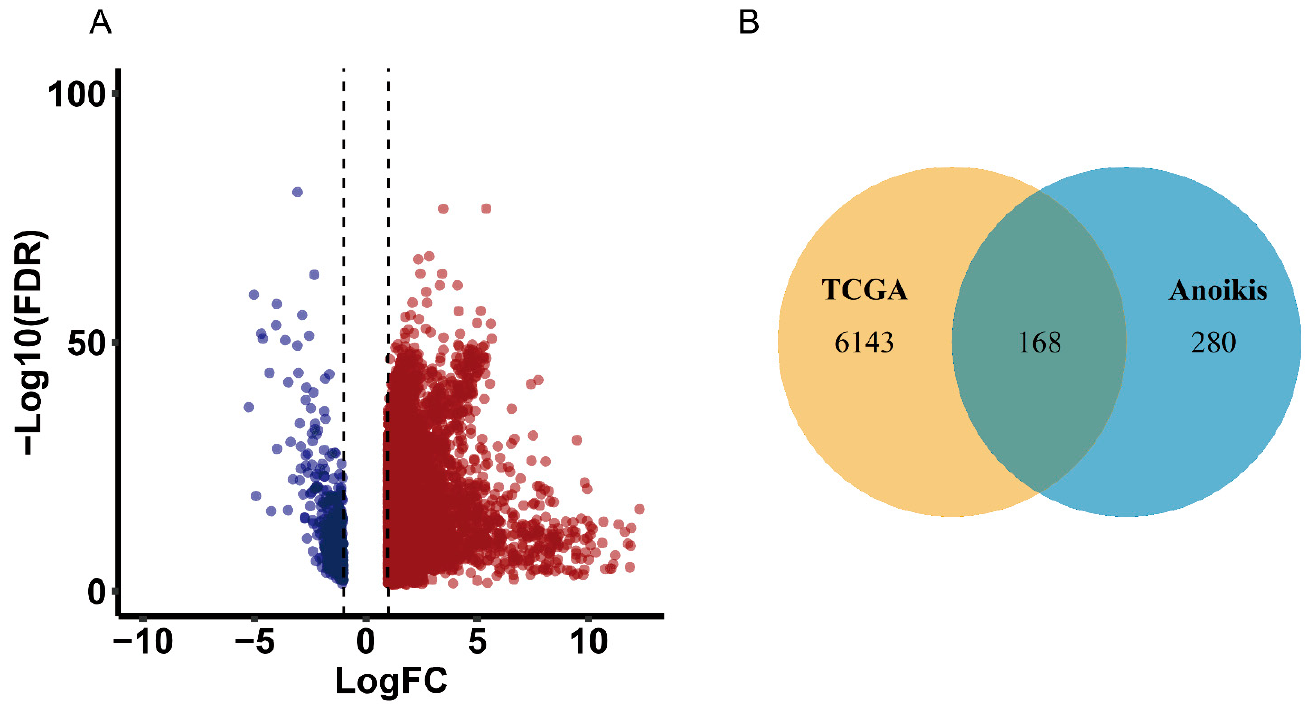
Figure 1. Identification of differentially expressed overlapping anoikis-related genes. ( A ) Volcano plot of differentially expressed genes in the TCGA dataset. Blue dots indicate statistically significant downregulated genes and red dots indicate statistically significant upregulated genes. The x -axis represents the logarithm of fold change of differentially expressed genes and the y -axis represents the adjusted p -value based on the FDR correction method. ( B ) Venn diagram of overlapping genes in the TCGA and anoikis-related genes.